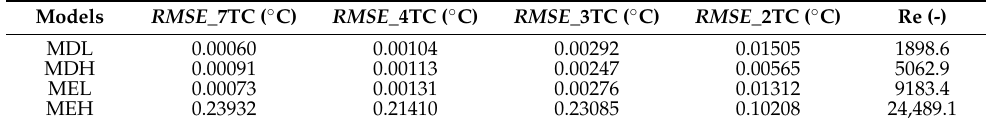
Table 4. RMSE ( ◦ C) in the estimation of thermocline thickness at the TC locations calculated with 7, 4, 3 and 2 TC with respect to those calculated with 12 TC in MDL, MDH, MEL and